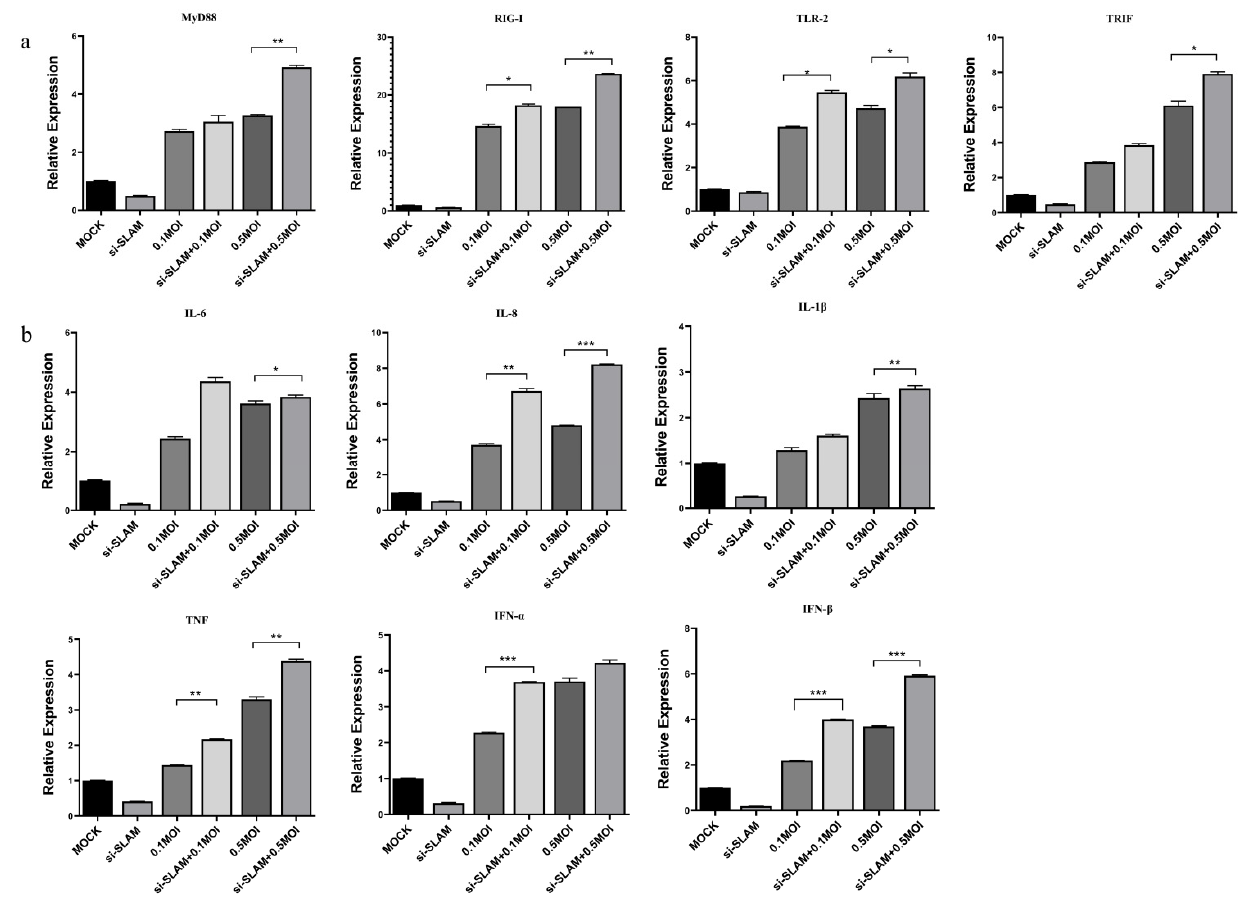
Figure 5. Knockdown of porcine SLAM promotes PRRSV-induced inflammation. ( a ) The effect of si-SLAM on key signaling molecules after PRRSV infection. ( b ) The effect of the si-SLAM gene on inflammatory factors after PRRSV infection. Note: * means significant difference ( p < 0.05); ** means significant difference ( p < 0.01); *** means an extremely significant difference ( p < 0.001).